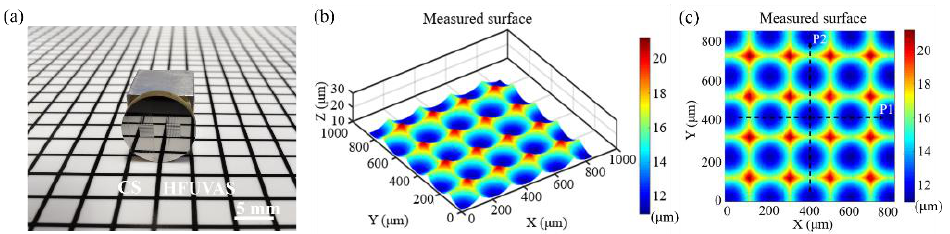
of lenslets along the feed direction (P1) and the cutting direction (P2) were measured and analyzed for further study.